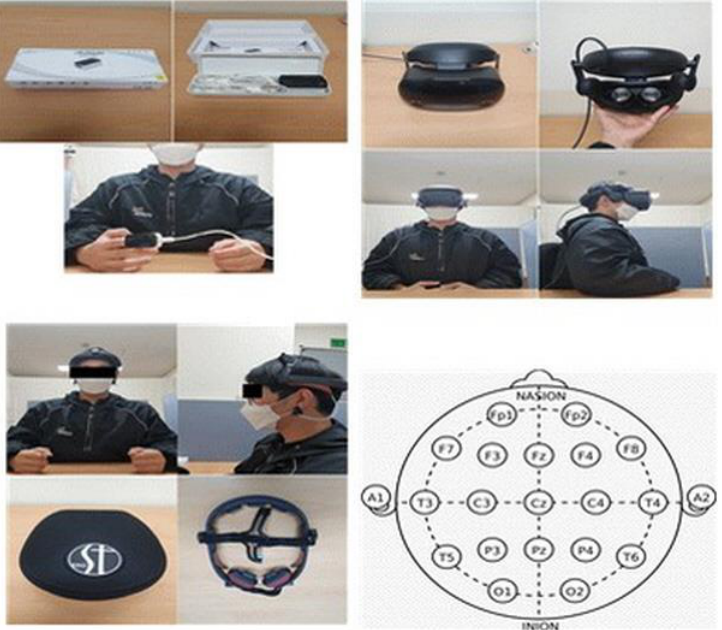
Figure 3. Appearance of wearing experimental equipment and international electrode placement method.